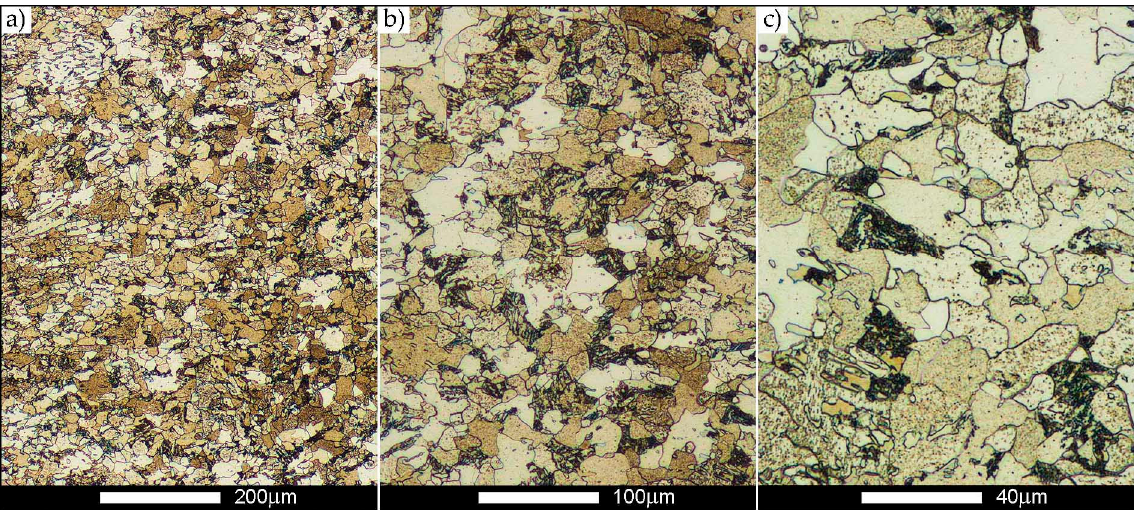
Figure 44. Welded joint microstructure of Hardox 450 steel in normalised state with visible prior austenite grain boundaries—WM3 zone shown in Figure 2. ( a ) 100×; ( b ) 200×; ( c ) 500×.